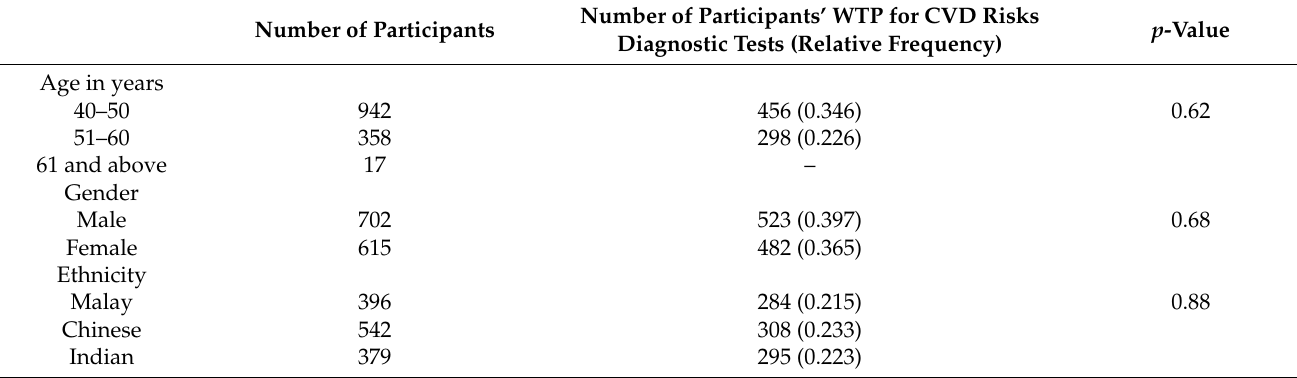
Table 3. One-way analysis of variance and T -test followed by Tukey’s post hoc